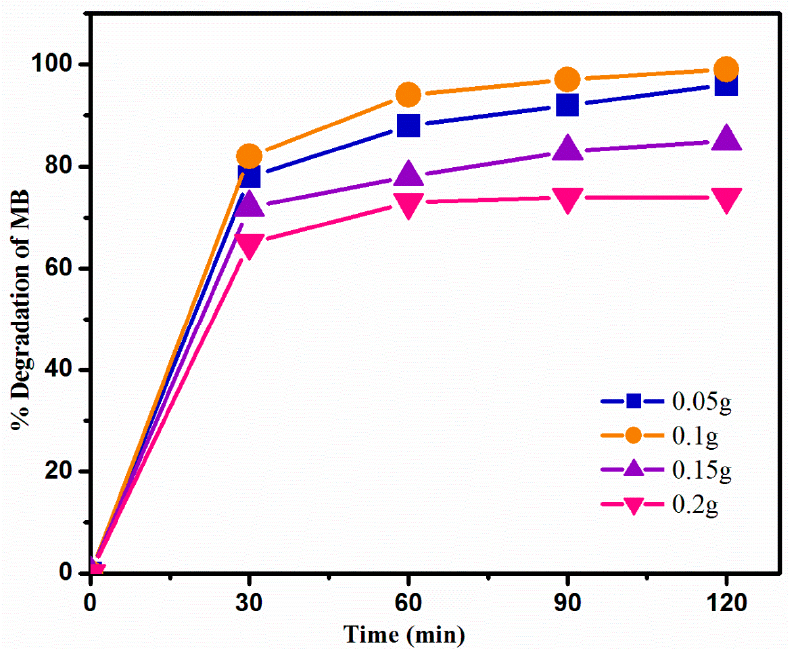
Figure 16. The plot of percentage degradation of MB by varying catalyst amounts in different time intervals.